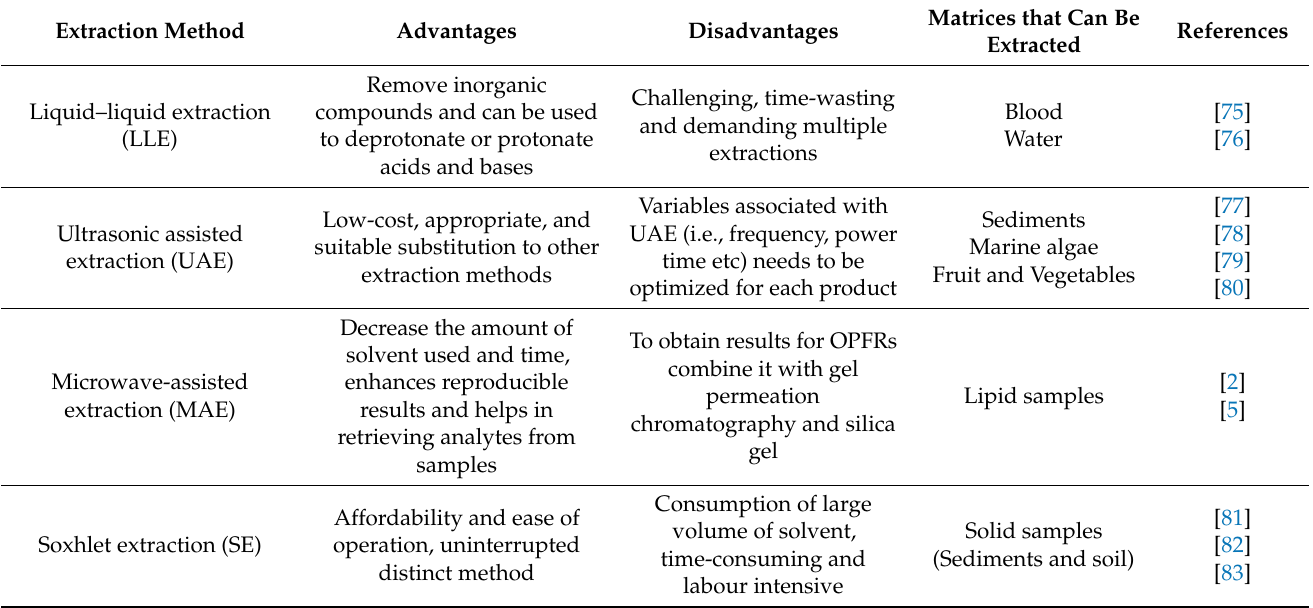
Table 5. Extraction methods used for OPFRs from different matrices, their advantages and